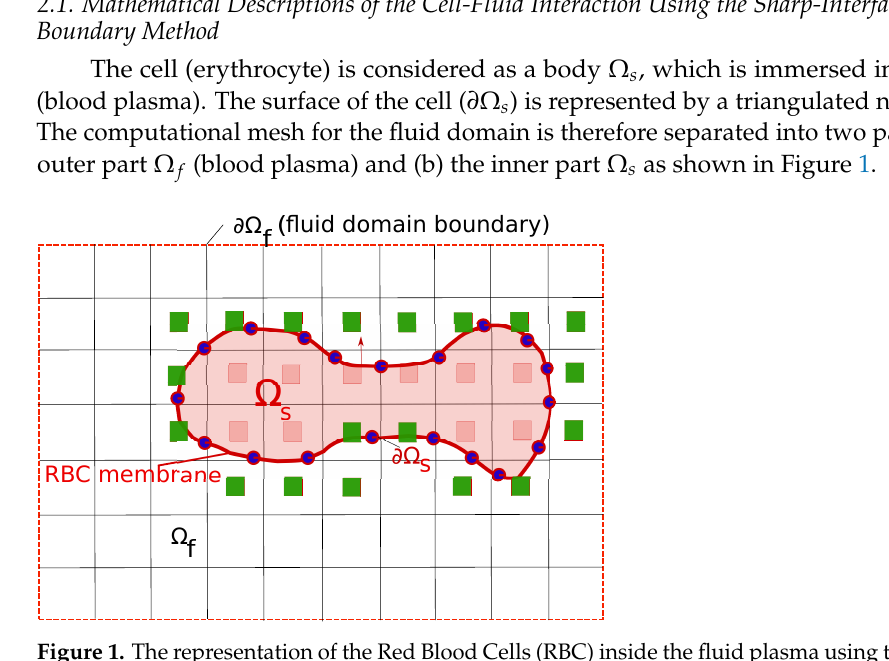
Figure 1. The representation of the Red Blood Cells (RBC) inside the fluid plasma using the Immersed Boundary Method (IBM). The RBC membrane is the surface of the solid domain ( ∂ Ω s ), which is depicted as a line connected by blue circles. The fluid domain is denoted as Ω f with the appropriate boundary conditions ∂ Ω f . The green squares represent the immersed nodes, which are the adjacent nodes to the cell surface ∂ Ω s . The no-slip boundary condition is enforced on ∂ Ω s